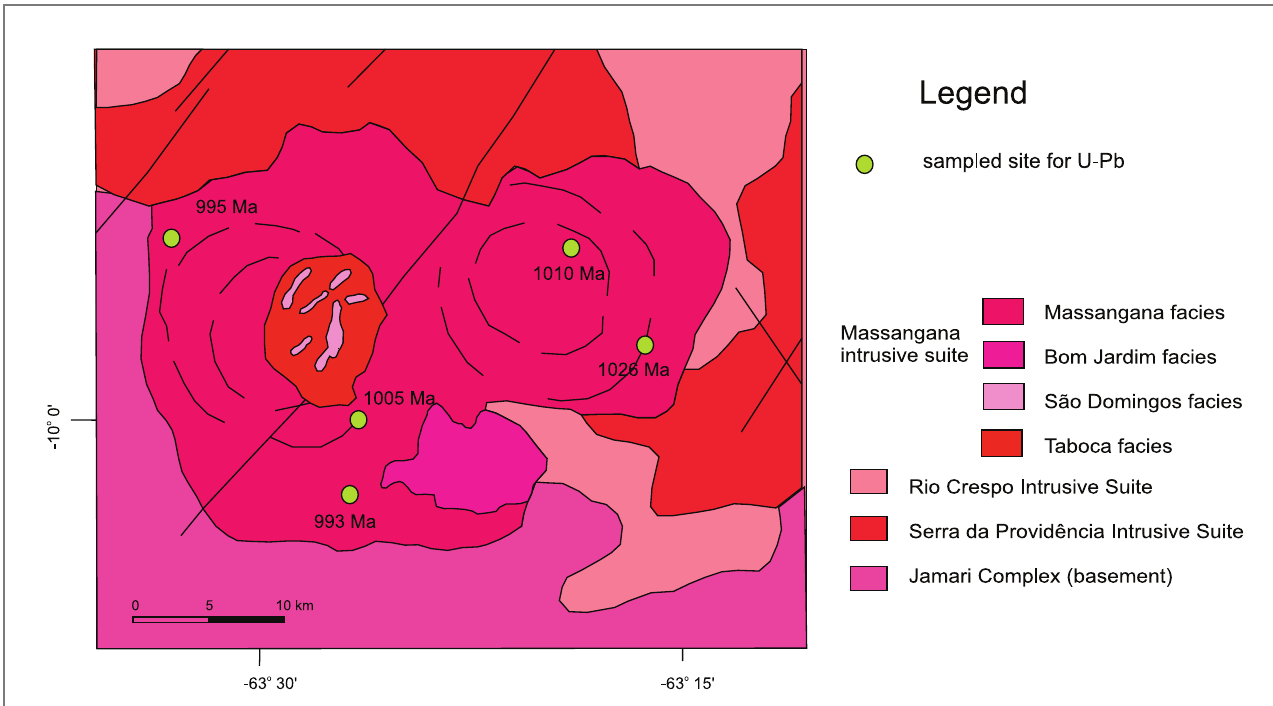
FIGURE 3 – Geologic map from Massangana massif adapted from Romanini (1982) and CPRM (2007) showing the distribuition of the analytical points of U-Pb and Lu-Hf analysis.